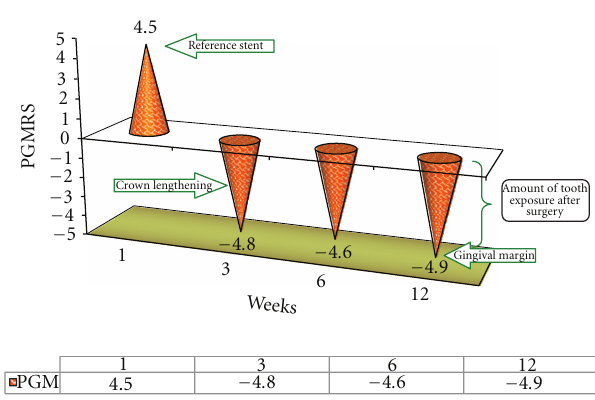
Figure 3: Deviation graph of position of gingival margin from reference stent (PGMRS) (B1 Group) at various intervals of weeks.